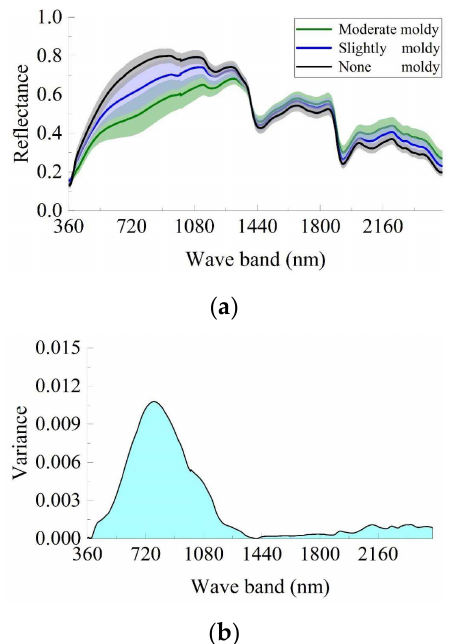
Figure 8. ( a ) Average reflectance spectral analysis curve. ( b ) Variance spectral analysis curve. 2 ∑ n S 2 = i = 1 ( x i − x )